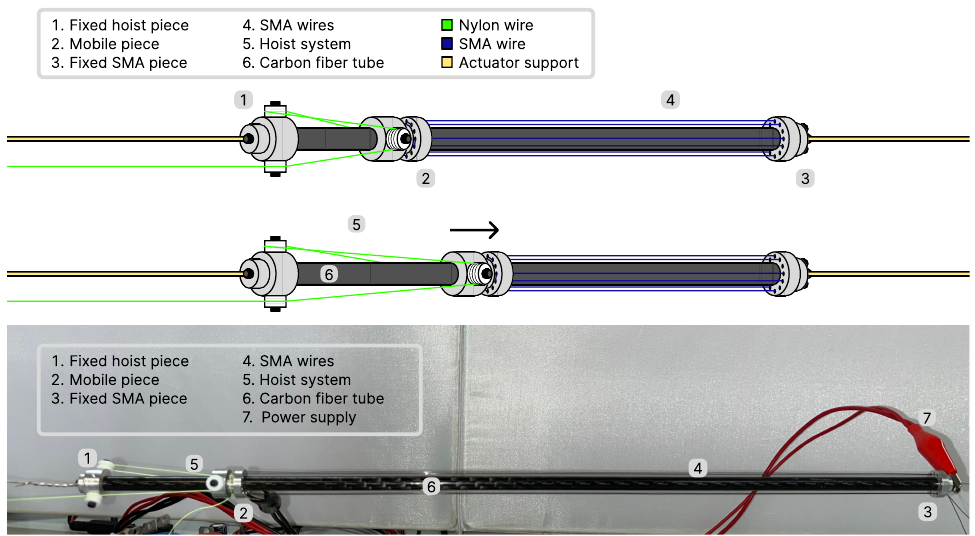
Figure 5. The actuator’s design and its main components, as well as a real photograph with a power